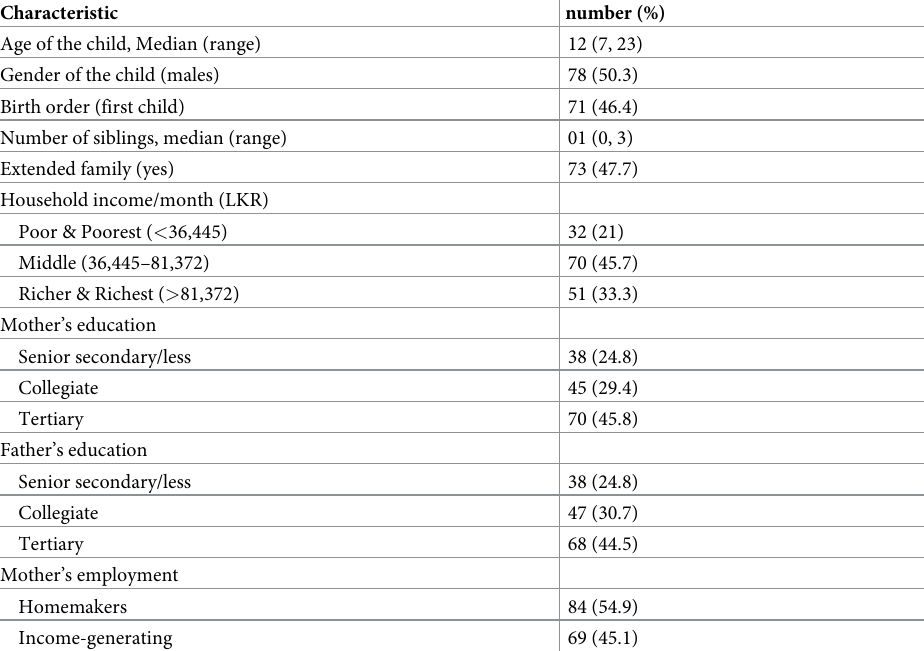
Table 1. Distribution of socio-demographic characteristics.